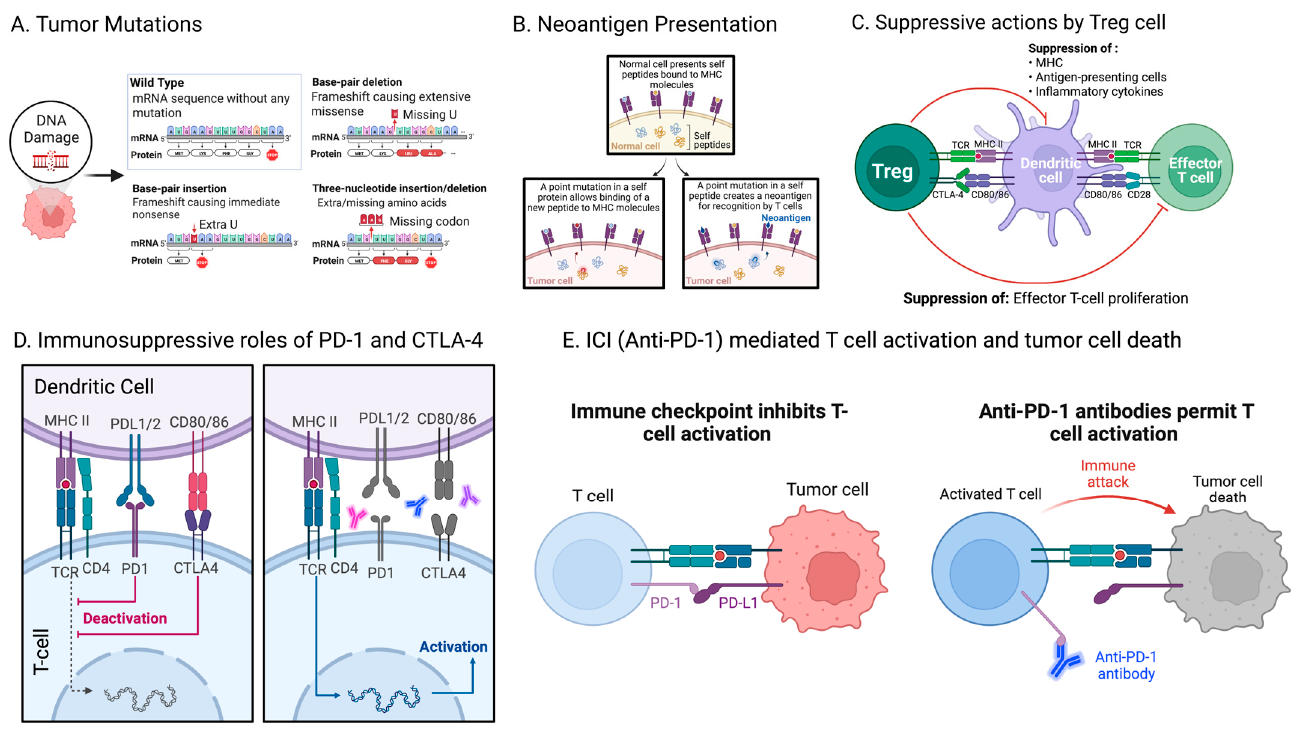
Figure 2. Neoantigens and current immune checkpoint inhibitors. ( A ) Tumor mutation burden (TMB) is the total number of somatic mutations found in the cancer cells’ DNA. ( B ) On the surface of tumor cells, neoantigens are presented and subsequently recognized by T cells. ( C ) Treg cells can reduce the cytotoxic T cell response against transformed cells. ( D ) Types of cancer treatment include surgery, chemotherapy, radiation, and immunotherapy. ICIs are a type of immunotherapy that promotes T cell activation. CTLA-4 and PD-1 signaling can be blocked by current ICIs. ( E ) PD-1 is an inhibitory checkpoint with an immunosuppressive role. Anti-PD-1 antibodies allow for T cell activation (Created with BioRender.com; (accessed on 15 January 2023)).